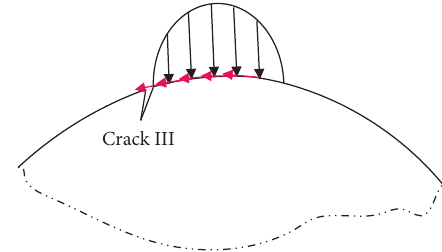
Figure 8: Stress process on crack surface for crack